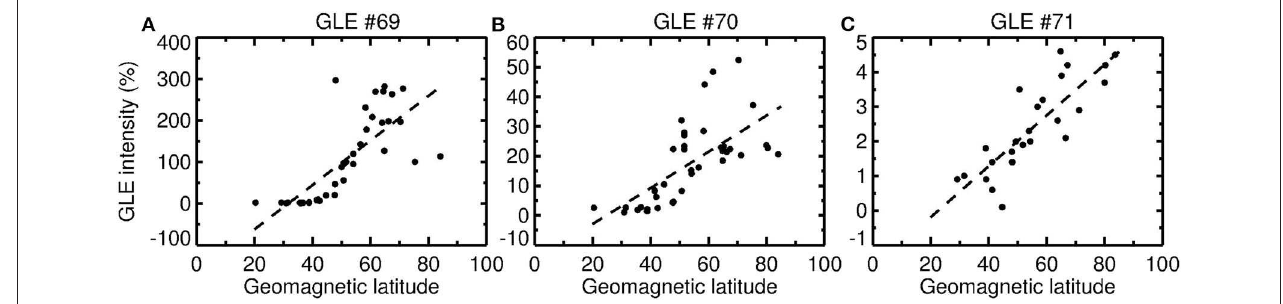
FIGURE 4 | Relation between geomagnetic latitude and GLE intensity for (A) GLE #69, (B) GLE #70 and (C) GLE #71. The black points represent all the NM stations which observed the corresponding GLE event. The black dashed line represents the linear fitting relation between geomagnetic latitude and GLE intensity for each